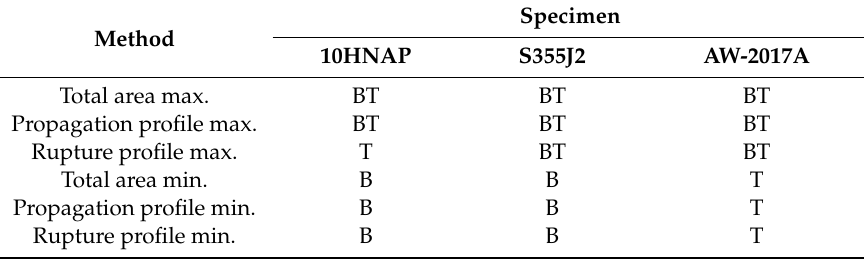
Figure 9. Surface parameters for the investigated fracture areas: ( a ) total area; ( b ) propagation profile; and ( c ) rupture profile. Table 5. List of maximum and minimum values of surface parameters for individual reference area.